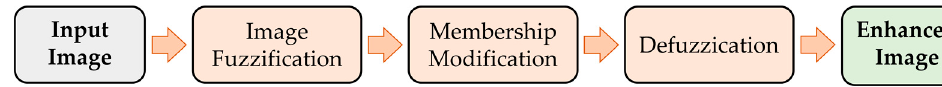
Figure 1. The main principles of fuzzy image enhancement